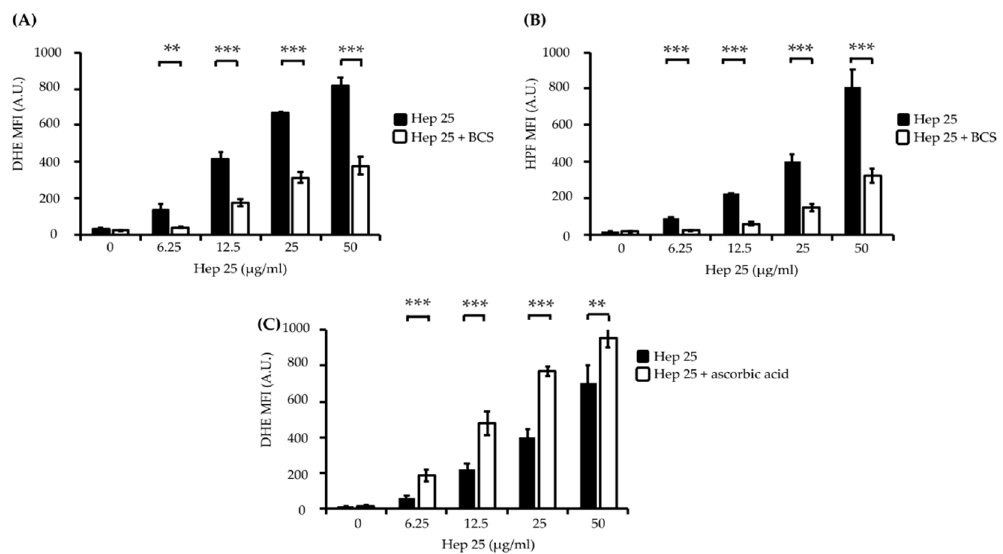
Figure 4. The induction of intracellular ROS production by hep 25. Intracellular ROS production was assessed through DHE ( A , C ) and HPF ( B ) staining and flow cytometry. The black bar and white bar show cells treated with hep 25 and cotreated with 1 mM BCS or 10 mM ascorbic acid and hep 25, respectively. MFI, mean fluorescence intensity and A.U., arbitrary unit. The results are presented as the mean ± standard deviation of three independent experiments; ** p < 0.01 and *** p < 0.001.